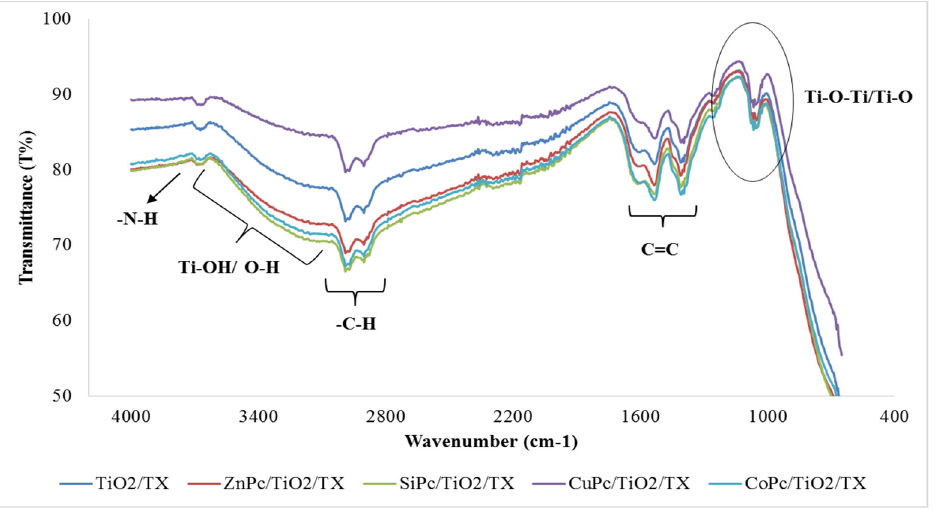
Figure 7. FT-IR spectrums of TiO 2 /TX-100 and MPc/TiO 2 /TX-100 catalysts prepared in the presence of surfactant.